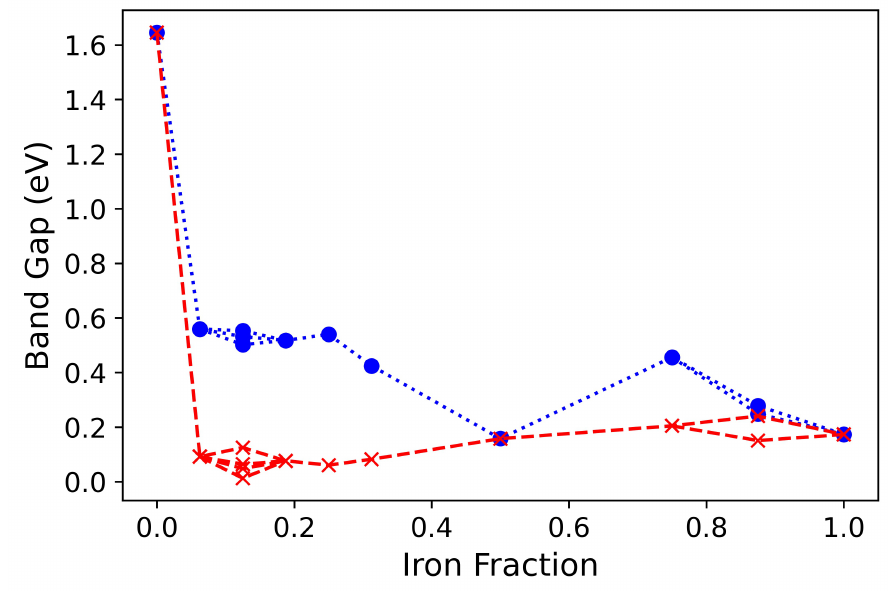
Figure 10. Band gap of the CuAl 1 − p Fe p S 2 obtained via uniformly distributed [ Fe Al ] 0 antisite defects (blue circles) and [ Fe Cu ] 2 + + [ Fe Cu ] 2 + defect complexes (red crosses). The multiple values at p = 0.125 and p = 0.875 correspond to the α 2.1 , α 2.2 , α 2.3 , β 2.1 , β 2.2 , β 2.3 and β 2.4 configurations and their inverted systems,